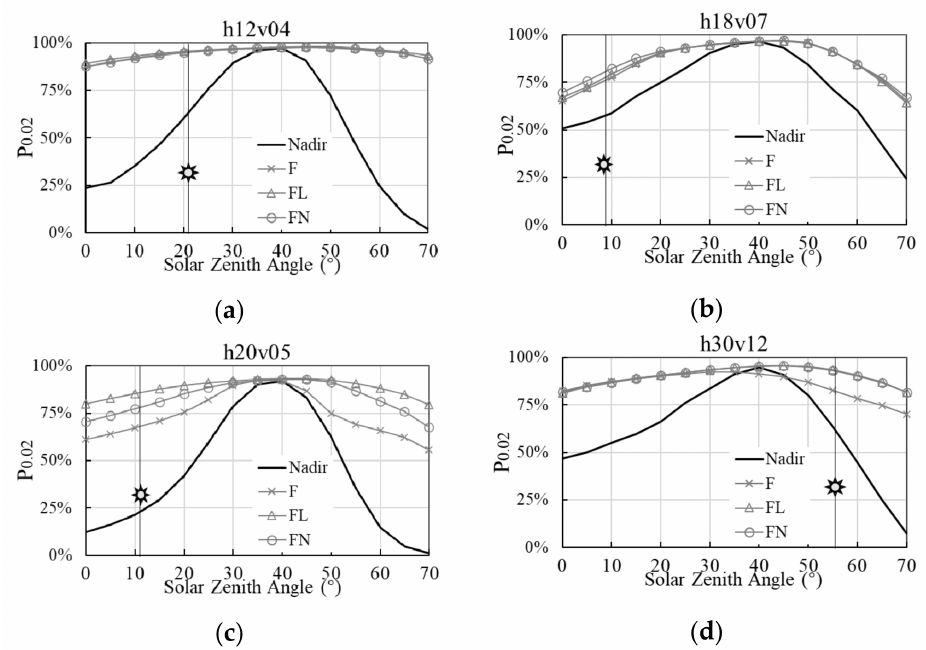
Figure 9. P 0.02 for nadir reflectance, F- , F L - , and F N - based albedo at various solar zenith angles. The sun symbol refers to the real solar zenith angle. ( a – d ) refer to the tile of h12v04, h18v07, h20v05 and h30v12.